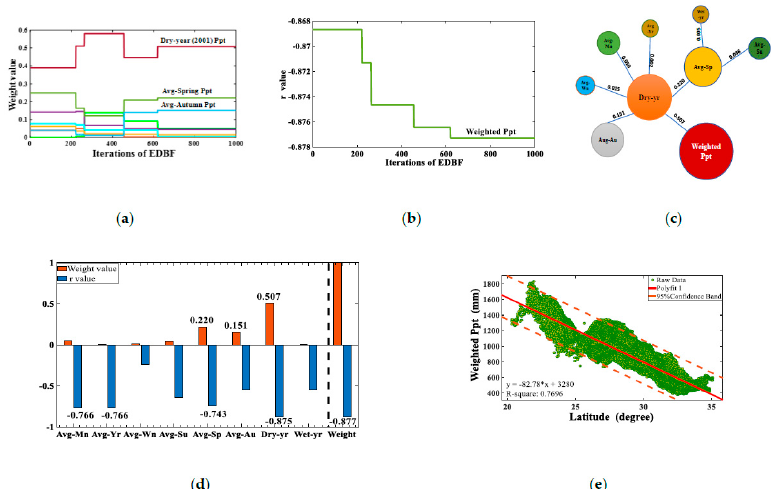
Figure 6. Execution of EBDF algorithm for predicting the high-resolution weighted precipitation at 0.05° resolution: ( a ) iteratively estimated weight values; ( b ) iteratively estimated r values; ( c ) the estimated final weight values; ( d ) the comparison between the estimated weights and r values; and ( e ) the relationship between the weighted precipitation and latitude, respectively. Table 2. Comparison between the weighted precipitation and the multitemporal precipitation variables at 0.75° resolution. Variables Statistical Parameters R-square Mean Bias